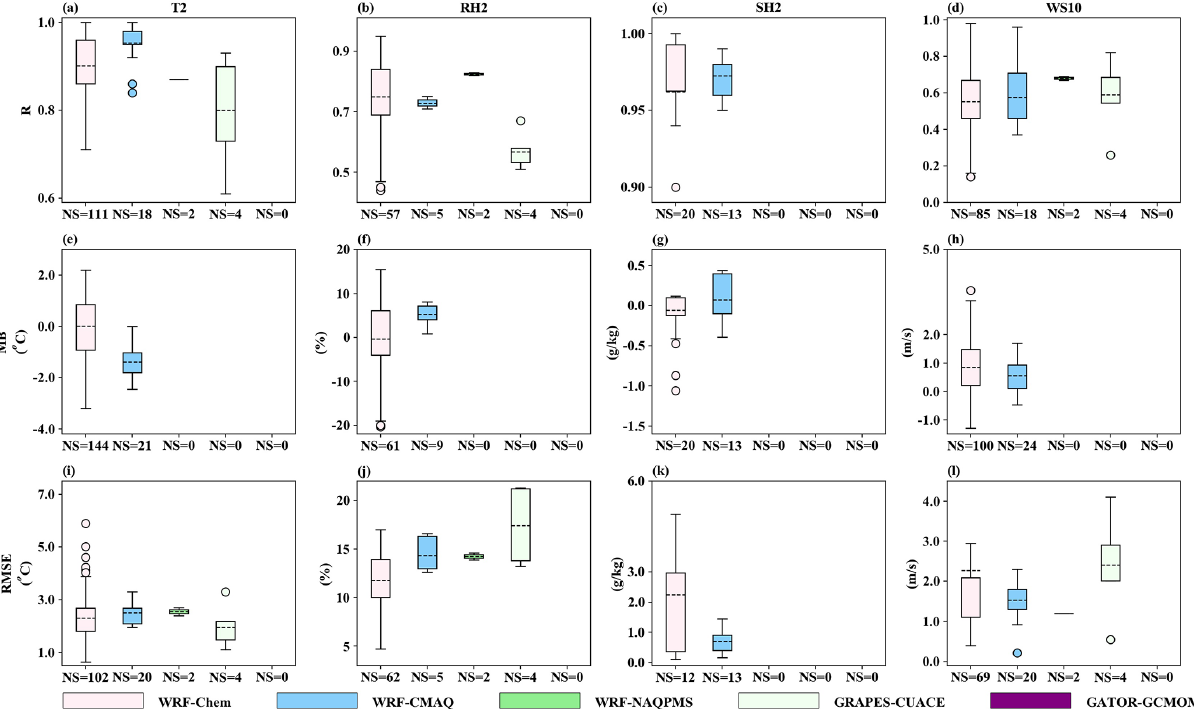
Figure 4. Quantile distributions of the statistical indices for simulated surface meteorological variables by WRF-Chem, WRF-CMAQ, GRAPES-CUACE, WRF-NAQPMS, and GATOR-GCMOM in